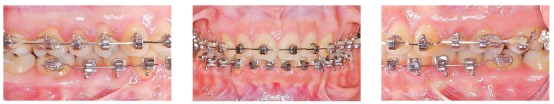
Intraoral photographs of the patient shown in Figures 12, 13 and 14 during the finishing stage of treatment. Note the chain elastics inserted under the finishing wire, as the dimensions of brackets do not allow their insertion over the wire.